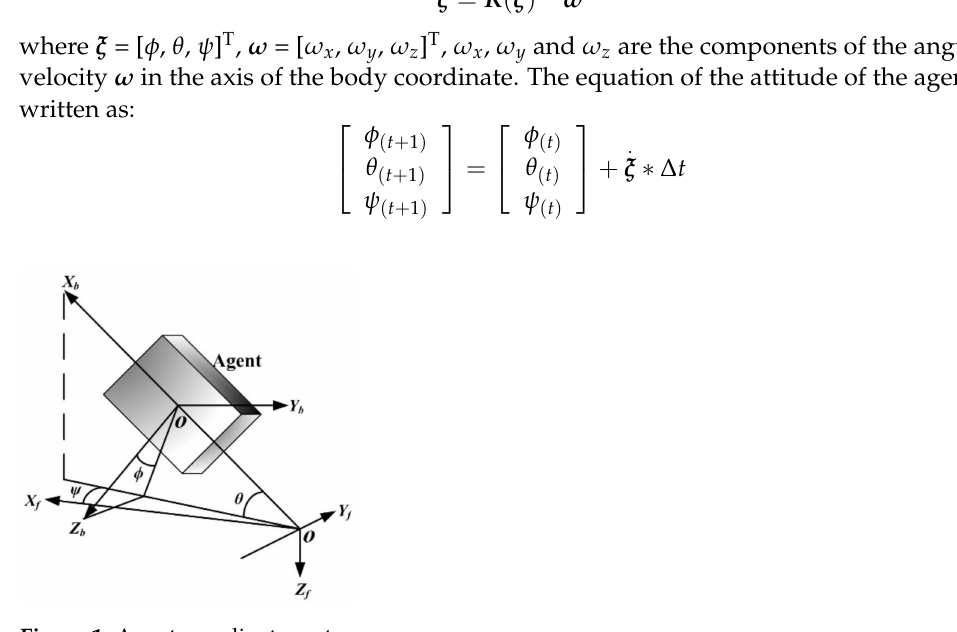
Figure 1. Agent coordinate